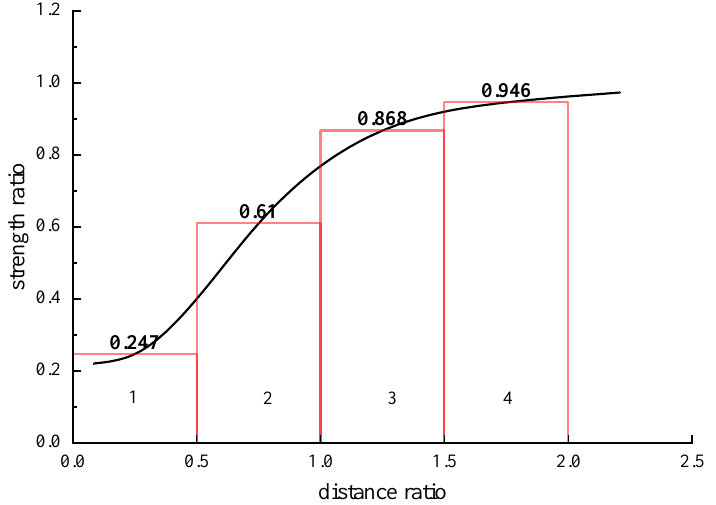
Figure 9. Compressive strength reduction curve of different distances (partition) around a pile.